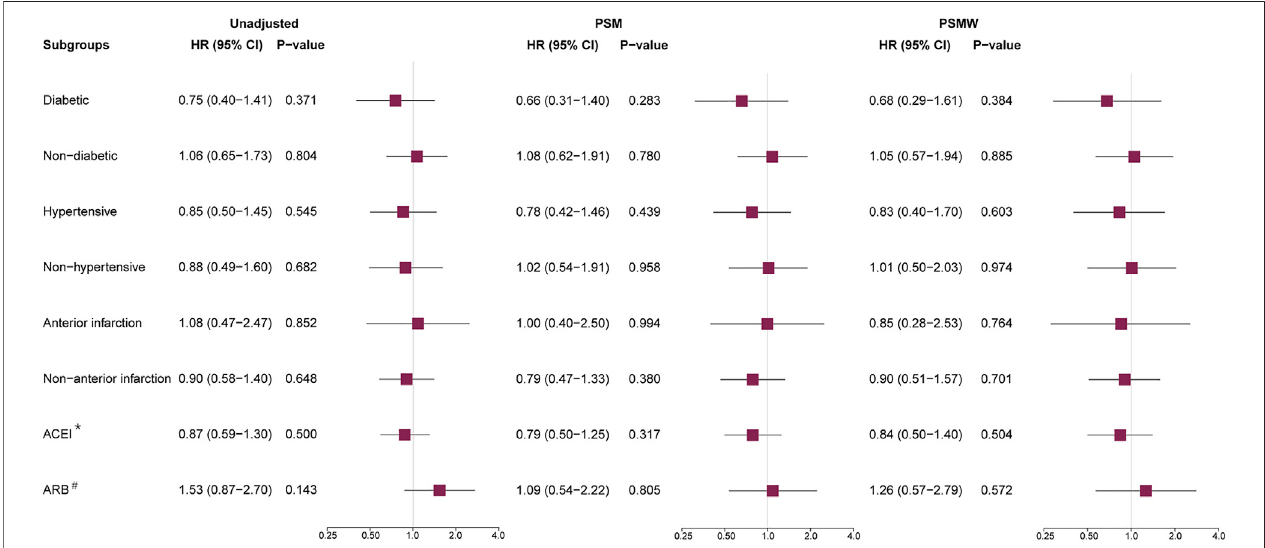
FIGURE4| Subgroupanalysisfortheprimaryoutcome.ACEI=angiotensinconvertingenzymeinhibitors,ARB=angiotensinreceptorblockers,PSM=propensity scorematching, PSMW=propensityscorematchingweight,HR=hazardratio,CI=con fi denceinterval.*:ACEI usersvs.ACEI/ARBnon-users.#:ARBusersvs. ACEI/ ARB